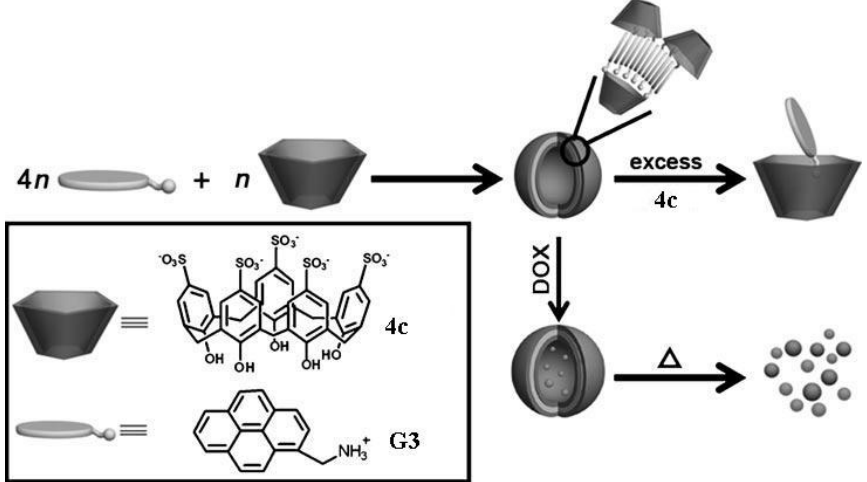
Figure 11. Formation of supramolecular binary vesicles made from pyrene derivative G3 and calixarene 4c (Reprinted with permission from ref. [75]. Copyright 2010